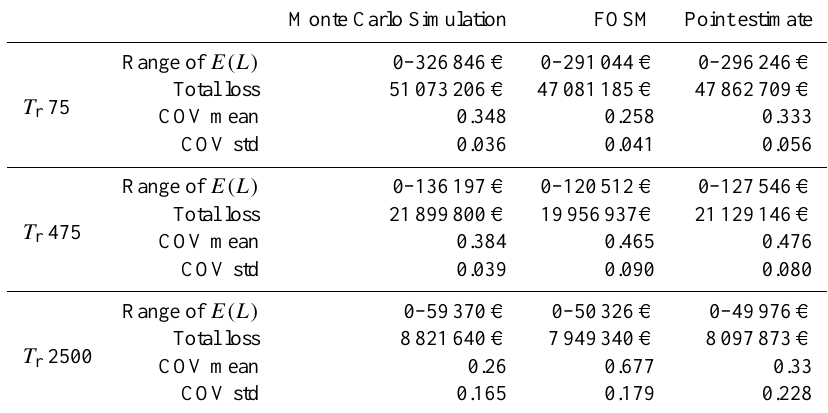
Table 6. Expected annual losses and COV values for seismic scenarios with return time ( T r ) 75, 475 and 2500yr, vulnerability model from Kappos et al., 2006. Range of values for all the census parcels, and total on the study area. Comparison of the three methods: Monte-Carlo- Simulation, First Order Second Moment, and point estimate Monte Carlo Simulation FOSM